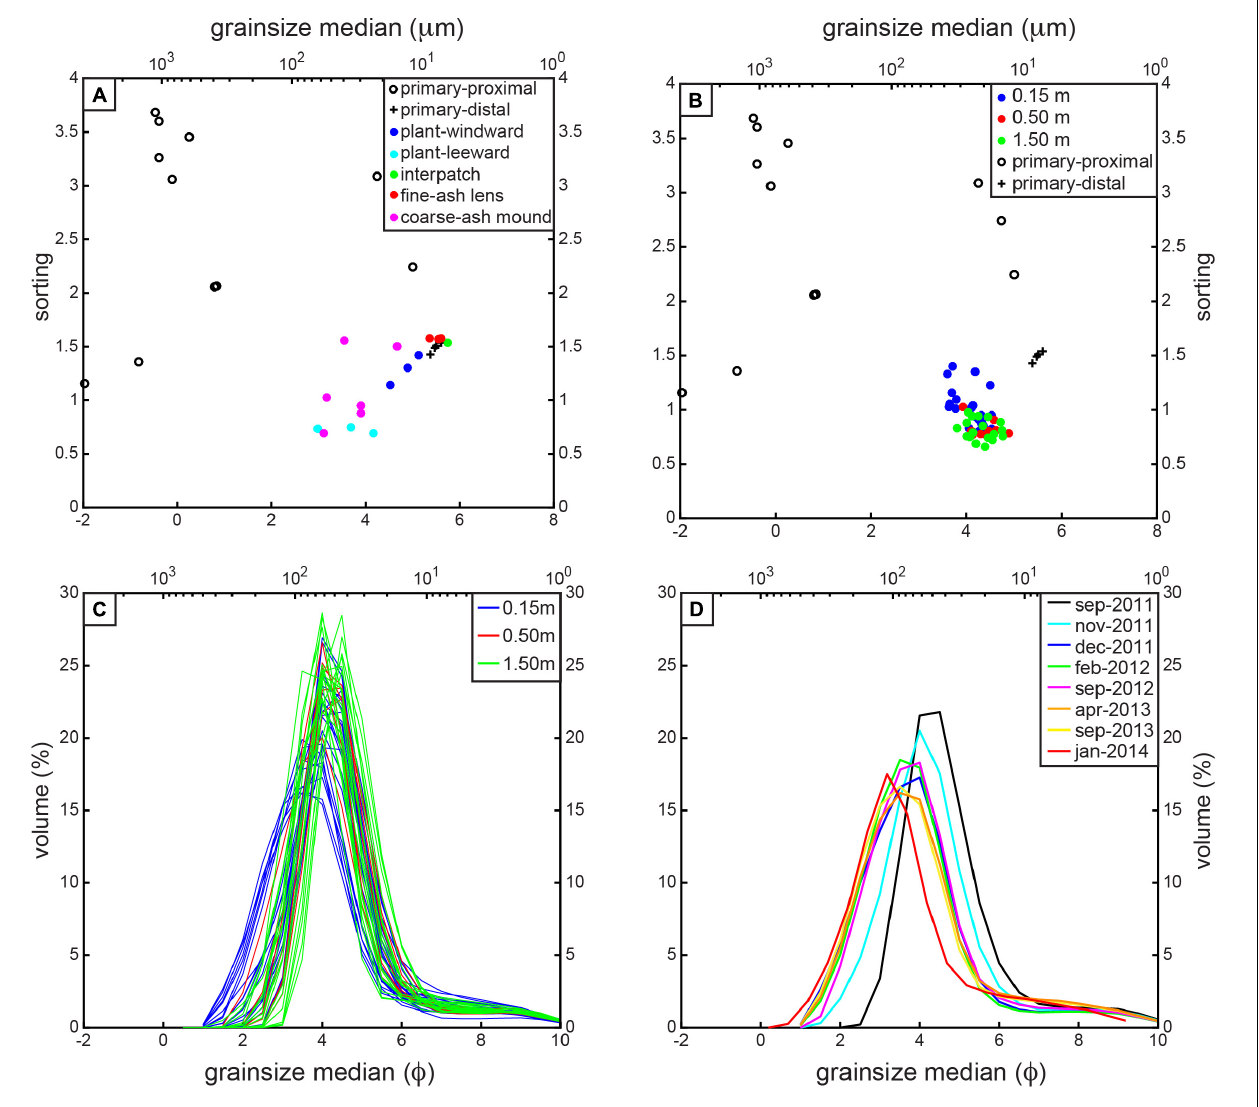
FIGURE 7 | Grainsize comparison between primary (i.e., Unit III) and remobilised ash: median grainsize versus sorting for the (A) ground samples and (B) airborne samples differentiated by type of deposit and collector height; (C) GSDs of the airborne samples for different collector heights; (D) evolution of grainsize as a function of time for airborne samples at the site S3. All x -axes are displayed in phi-scale (bottom) and microns (top), φ = –log 2 D/D 0 , where D 0 = 1 mm. Sorting, calculated as the Inman graphic standard deviation in phi units, α φ = (P84 – P16)/2 where P16 and P84 correspond to 16th and 84th percentiles, respectively (Inman,